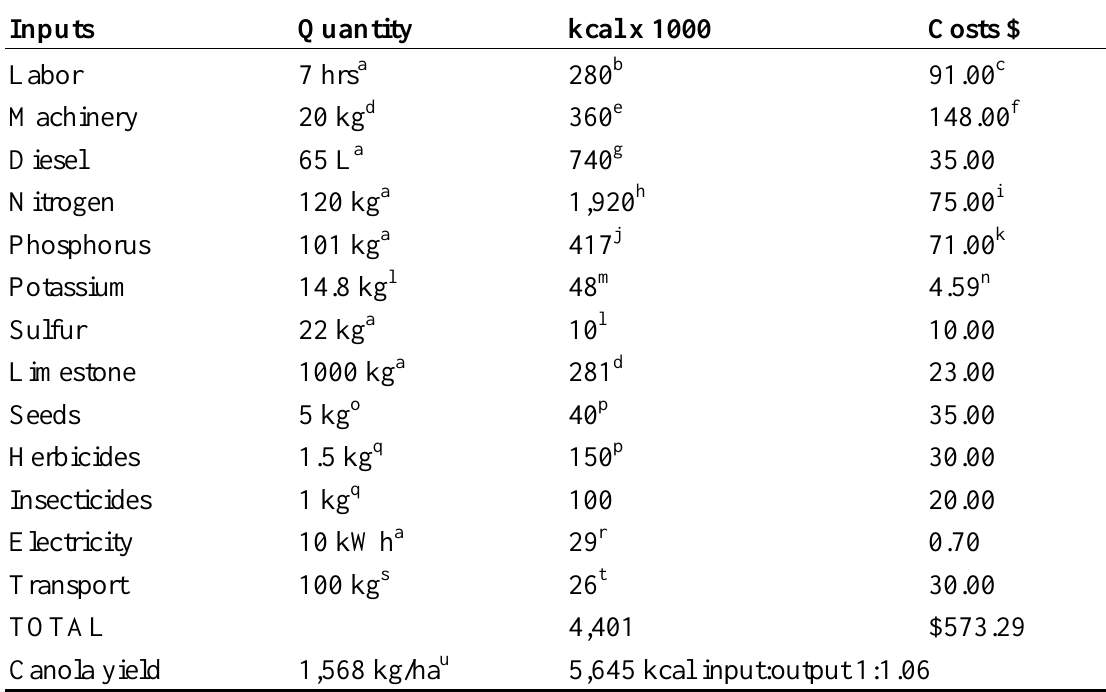
Table 10. Energy inputs and costs in canola production per hectare in the North